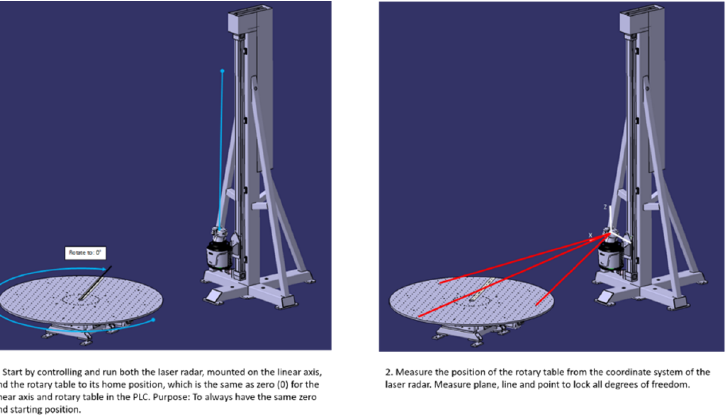
Figure 23. Description of system calibration procedure and update of the digital twin. First and second working steps (moving from the left illustration to the right illustration).